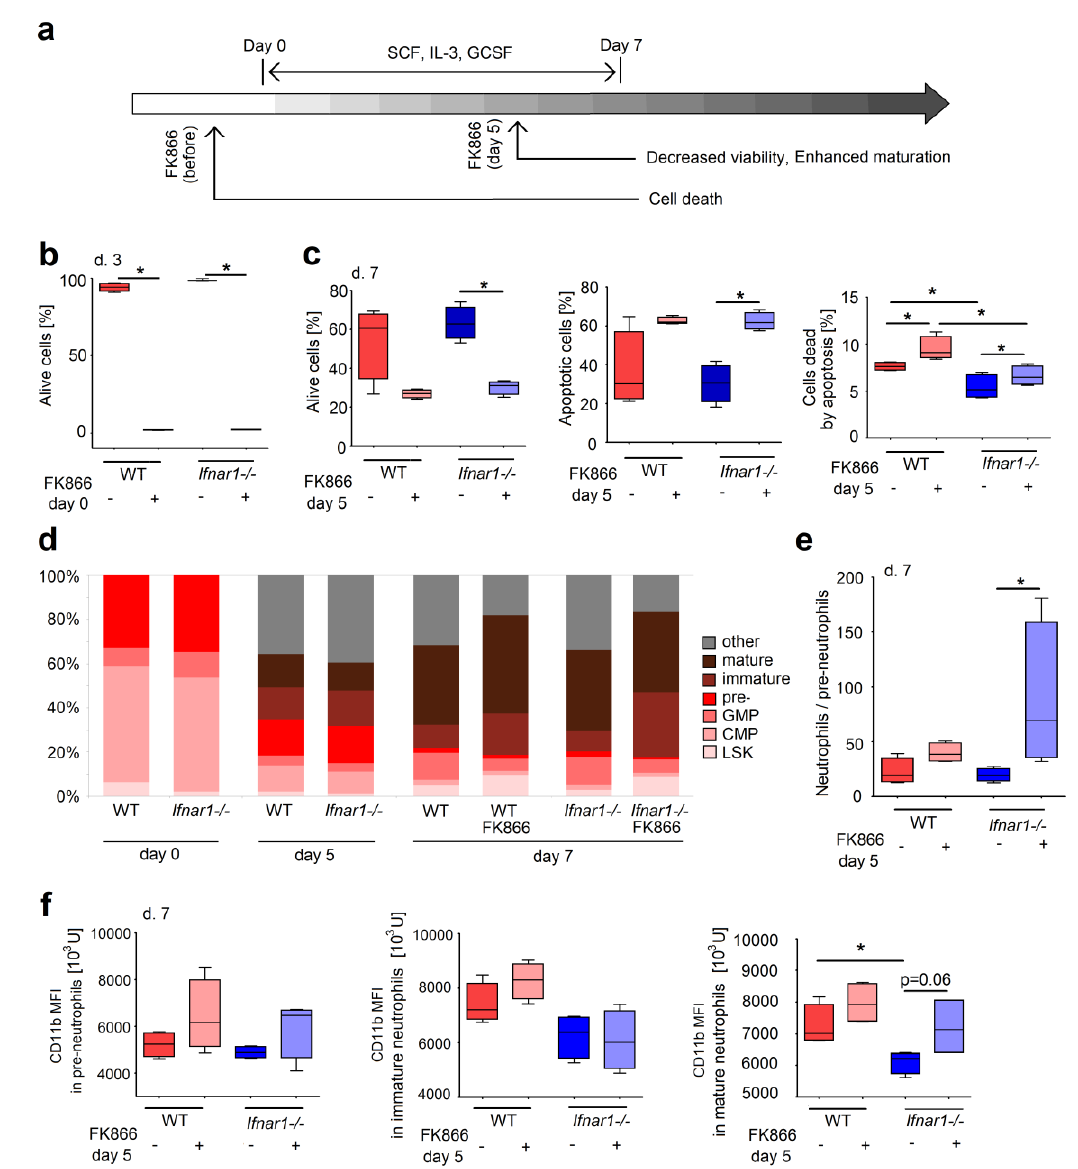
Figure 4. NAMPT inhibition results in apoptosis of early progenitors and maturation of di ff erentiated neutrophils. ( a ) The scheme of the experiment. Progenitor cells were isolated from bone marrow of wild-type (WT) and Ifnar1 - / - mice. Maturation was induced by stem cell factor (SCF) and IL-3, followed by G-CSF supplementation. Treatment with FK866 was performed at days 0 and 5; ( b ) FK866 treatment of isolated progenitors led to cell death. Cells were stained with annexin V and viability dye 7-AAD. Data are presented as a percentage of alive (annexin V – / 7-AAD – ) cells from all single cells; ( c ) FK866 treatment in late stages of neutrophils di ff erentiation increases apoptosis in cells from WT mice in comparison to cells from Ifnar1 - / - mice. Data are presented as a percentage of alive (annexin V – / 7-AAD – ), apoptotic (early apoptosis, annexin V + / 7-AAD – ), and dead by apoptosis (late apoptosis, Annexin V + / 7-AAD + ) cells from all single cells; ( d ) The relative amount of neutrophils progenitors in di ff erent stages of maturation of cells from WT and Ifnar1 - / - mice; ( e ) FK866 treatment in late stages of neutrophils di ff erentiation increases the ratio of neutrophils (immature + mature) in relation to pre-neutrophils in Ifnar1 - / - mice; ( f ) CD11b expression on pre-, immature and mature neutrophils di ff erentiated from progenitors from WT and Ifnar1 - / - mice. FK866 treatment in late stages of neutrophils di ff erentiation led to increased CD11b expression on mature neutrophils from Ifnar1 - / - mice. n = 4. Data are presented as median, 25th and 75th percentiles, and minimal and maximal values. * p <